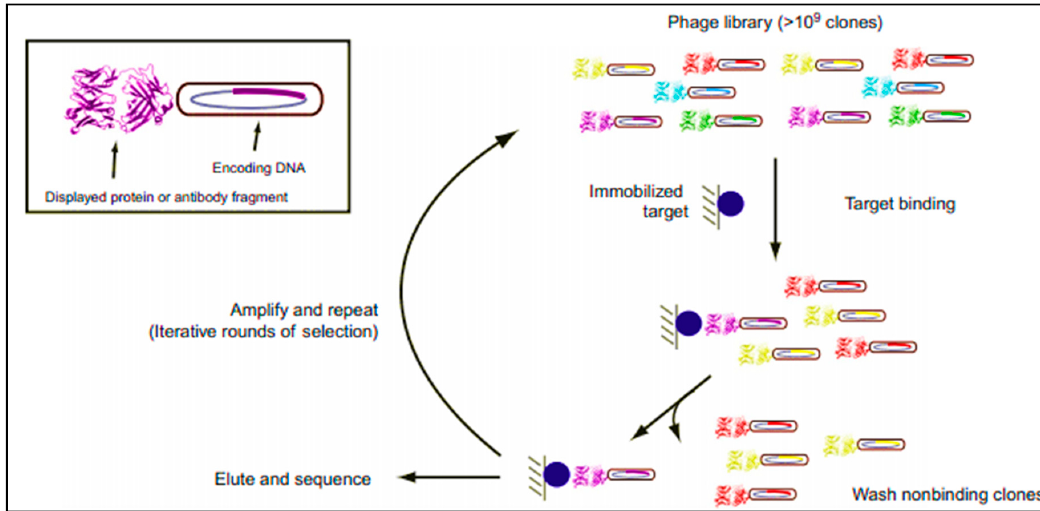
Scheme 1. Schematic representation of phage display process. It consists of cycles, each including: incubation of the antibody (Ab) repertoire and the target, washing of nonspecific binders, elution, and amplification of specific binders for further cycle or for screening [40].